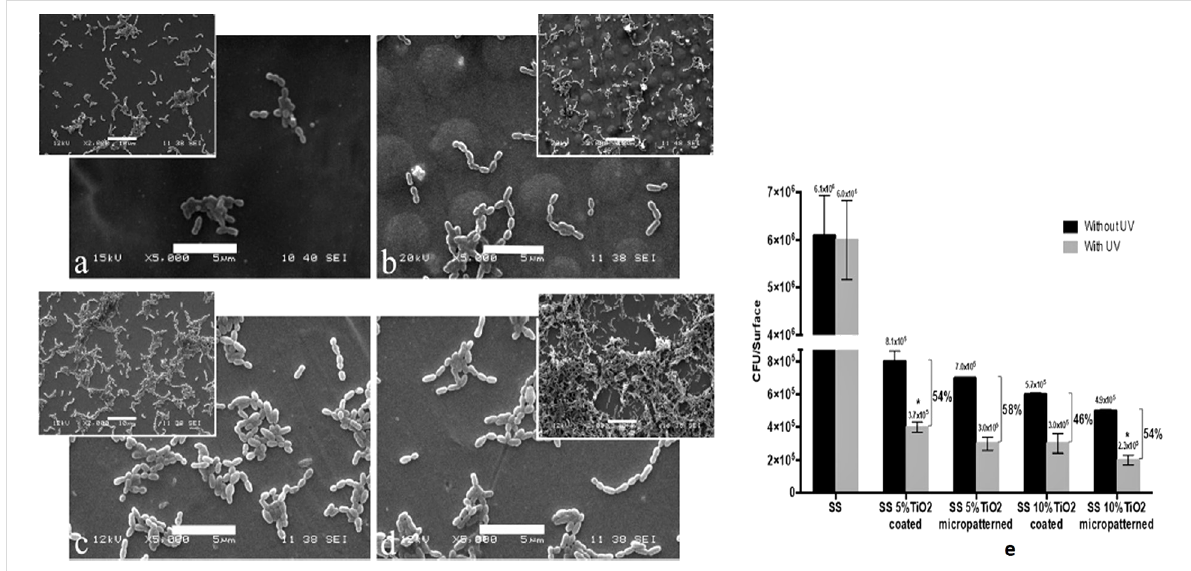
Figure 3: SEM images of the bacterial colonization on (a) coated SS-TiO 2 , (b) micropatterned SS-TiO 2 , (c) polished SS, and (d) unexposed polished SS. The scale is 5 µm. Inserts show interaction at 2000×. The scale in the inserts is 10 µm. (e) Viable adhered bacteria on coated SS-TiO 2 and SS-TiO 2 micropatterned with different TiO 2 concentrations after exposure to UV light. The percentages indicate the decrease of viable adhered bacteria due to UV exposure. All samples without UV are statistically significantly different. *Statistically significant difference compared to all